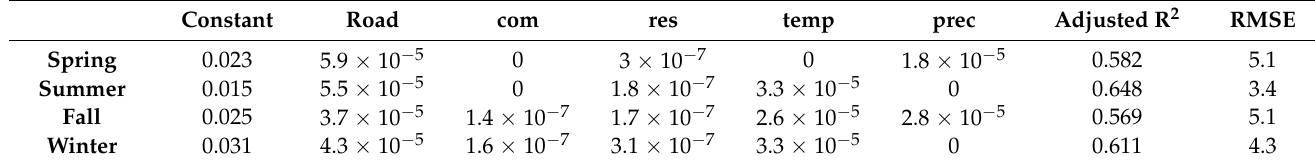
Table 3. Seasonal LUR model results. Constant and coefficient of variables with significant p -value for the seasonal models and the model validation metrics (adjusted R 2 and